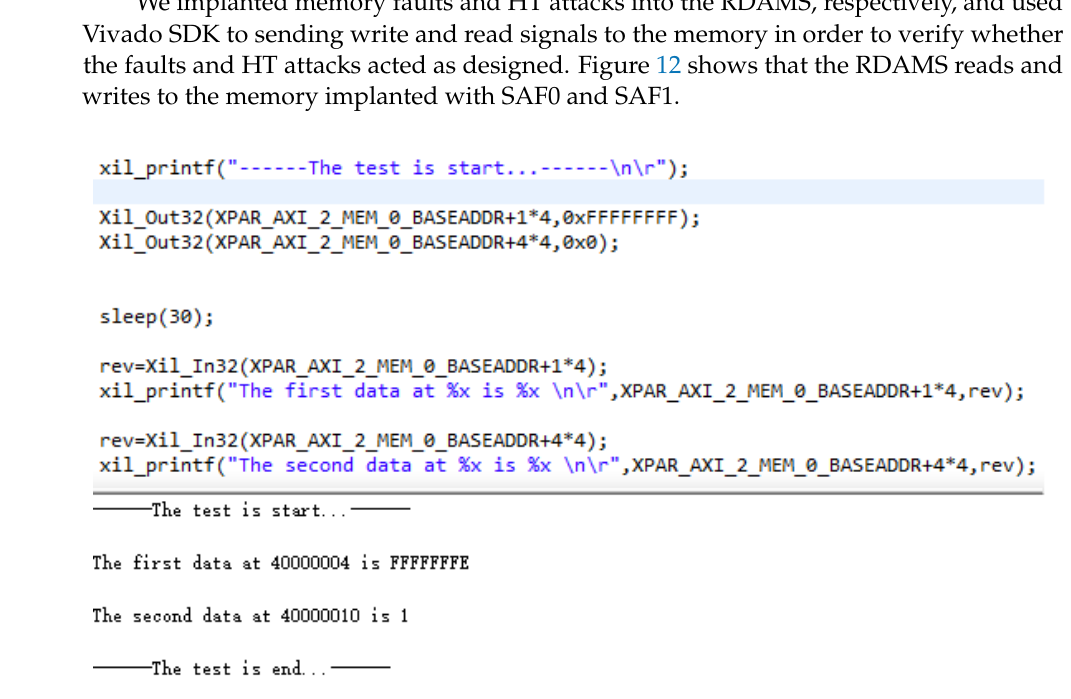
Figure 12. Read result of RDAMS implanted with stuck at fault (SAF)0 and SAF1.